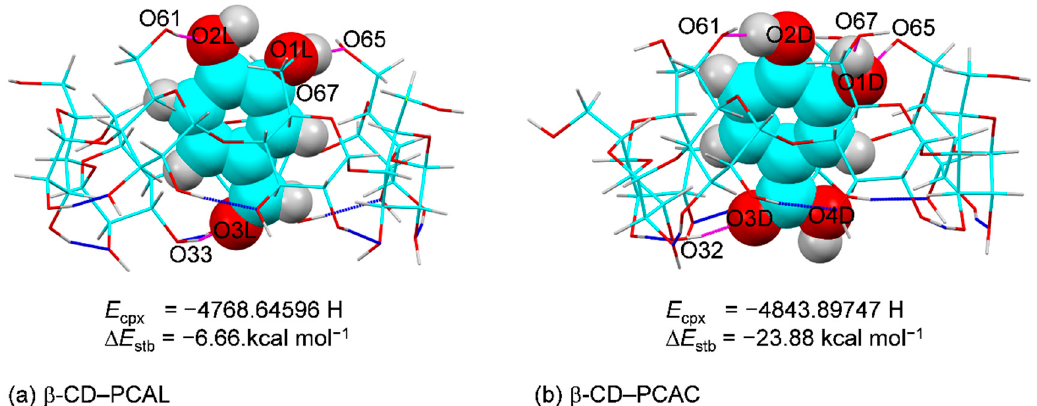
Figure 7. Inclusion complexes of ( a ) β -CD − PCAL and ( b ) β -CD − PCAC derived from DFT full-geometry optimization in the gas phase. For comparison, the energy of complex ( E cpx ) and stabilization energy ( Δ E stb ) are given; see also Figure S1 and Tables S5 and S6. The intramolecular O3( n )···O2( n + 1) H-bonds of β -CD and host–guest O–H···O H-bonds are indicated by blue and magenta connecting lines, respectively.